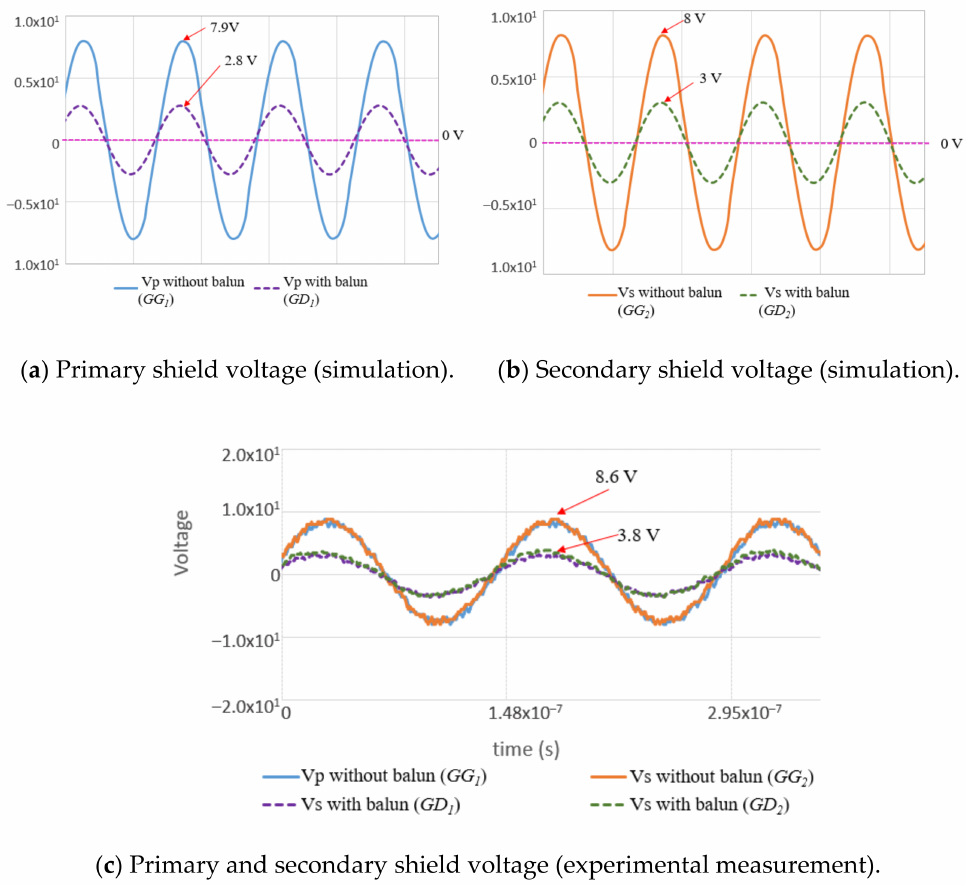
Figure 18. Shield plate voltage. ( a ) Primary shield voltage in the simulation. ( b ) Secondary shield voltage in the simulation. ( c ) Shield voltage in the